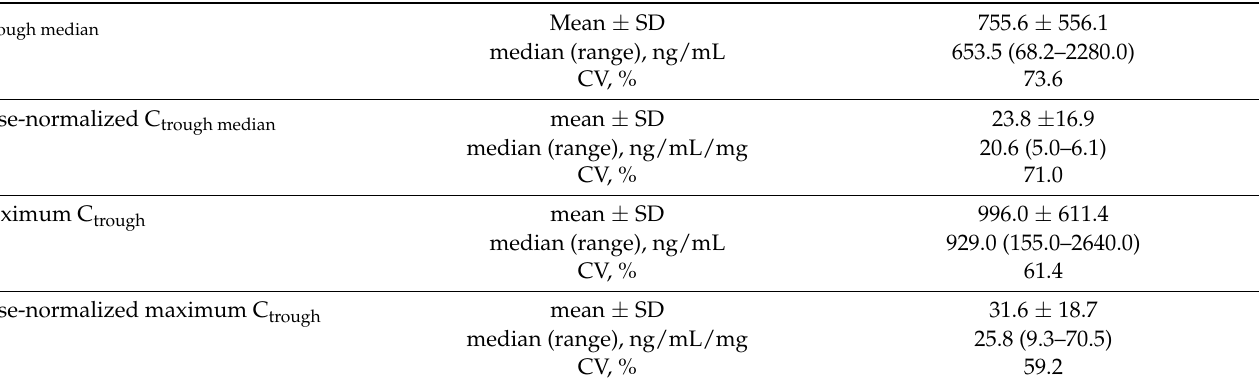
Figure 1. Time course of plasma trough concentrations of cabozantinib during treatment. Black squares indicate the point of the first dose reduction or interruption. Table 4. Pharmacokinetic parameters during cabozantinib therapy.